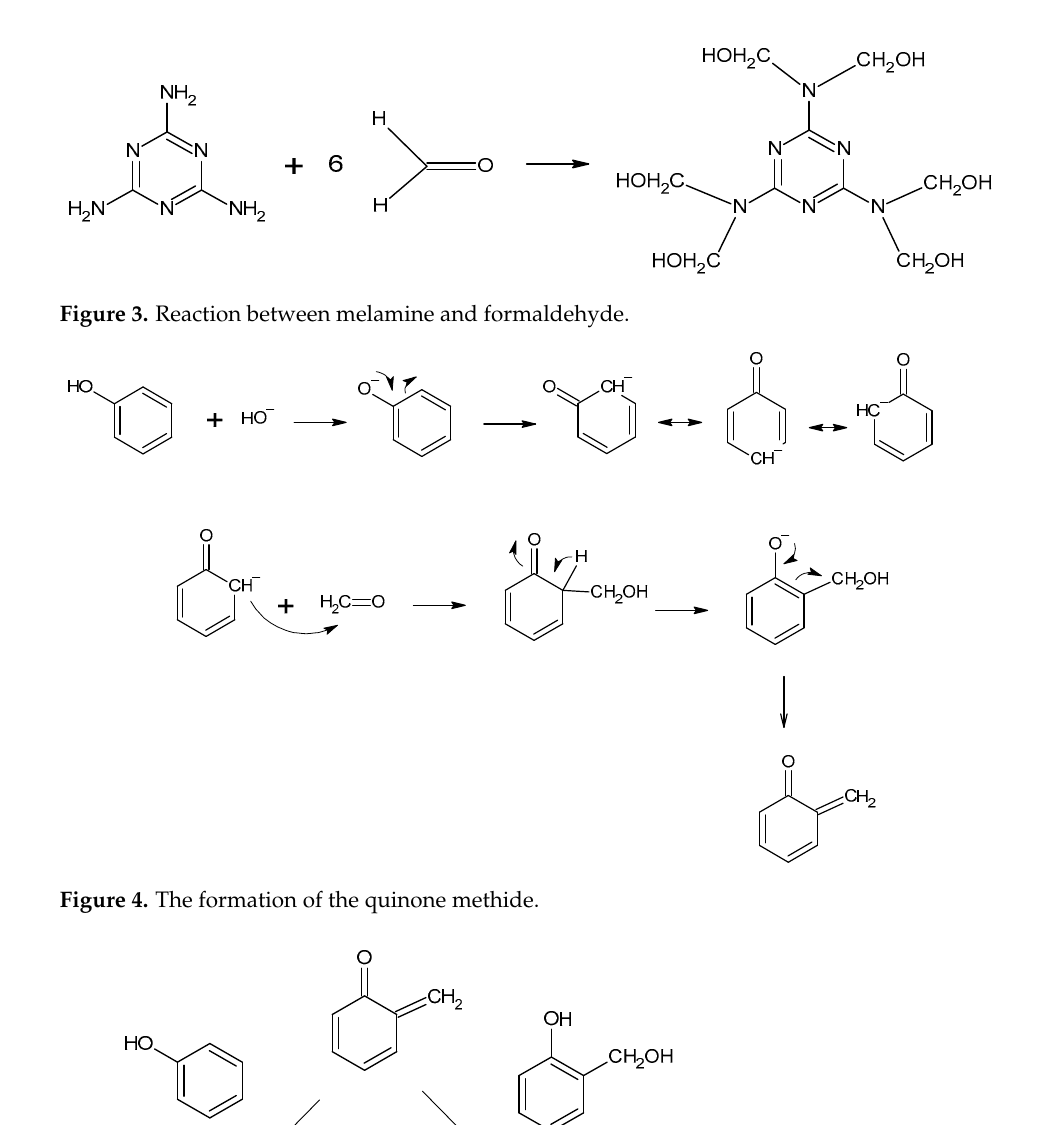
Figure 4. The formation of the quinone methide.